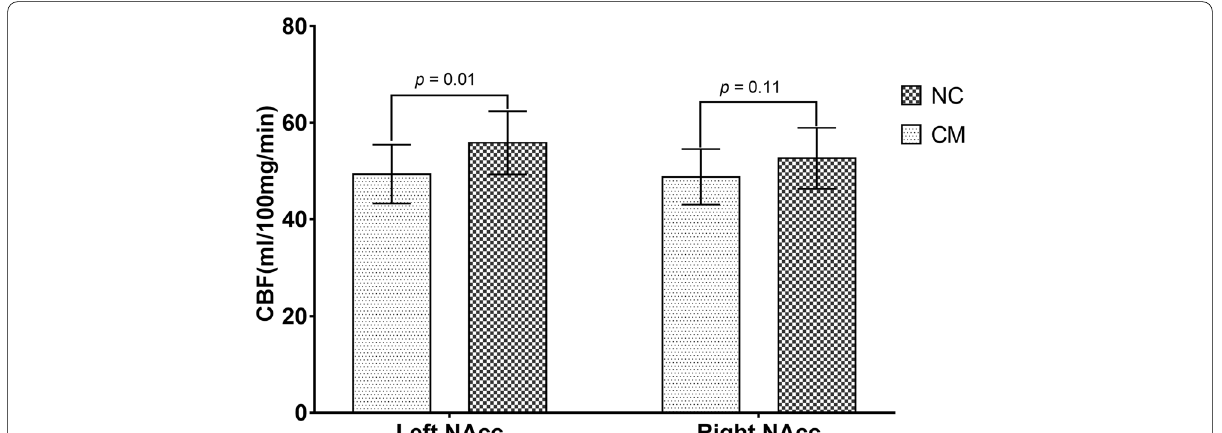
Fig. 2 The CBF value of bilateral nucleus accumbenses in CM and NC. The left NAcc presented significant hypoperfusion ( p NAcc showed no significant hypoperfusion ( p 0.11). NAcc, nucleus accumbens; CM, chronic migraine; NC, normal control; CBF, cerebral blood =